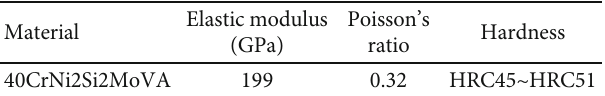
Table 6: 40CrNi2Si2MoVA mechanical properties parameters. Elastic Material